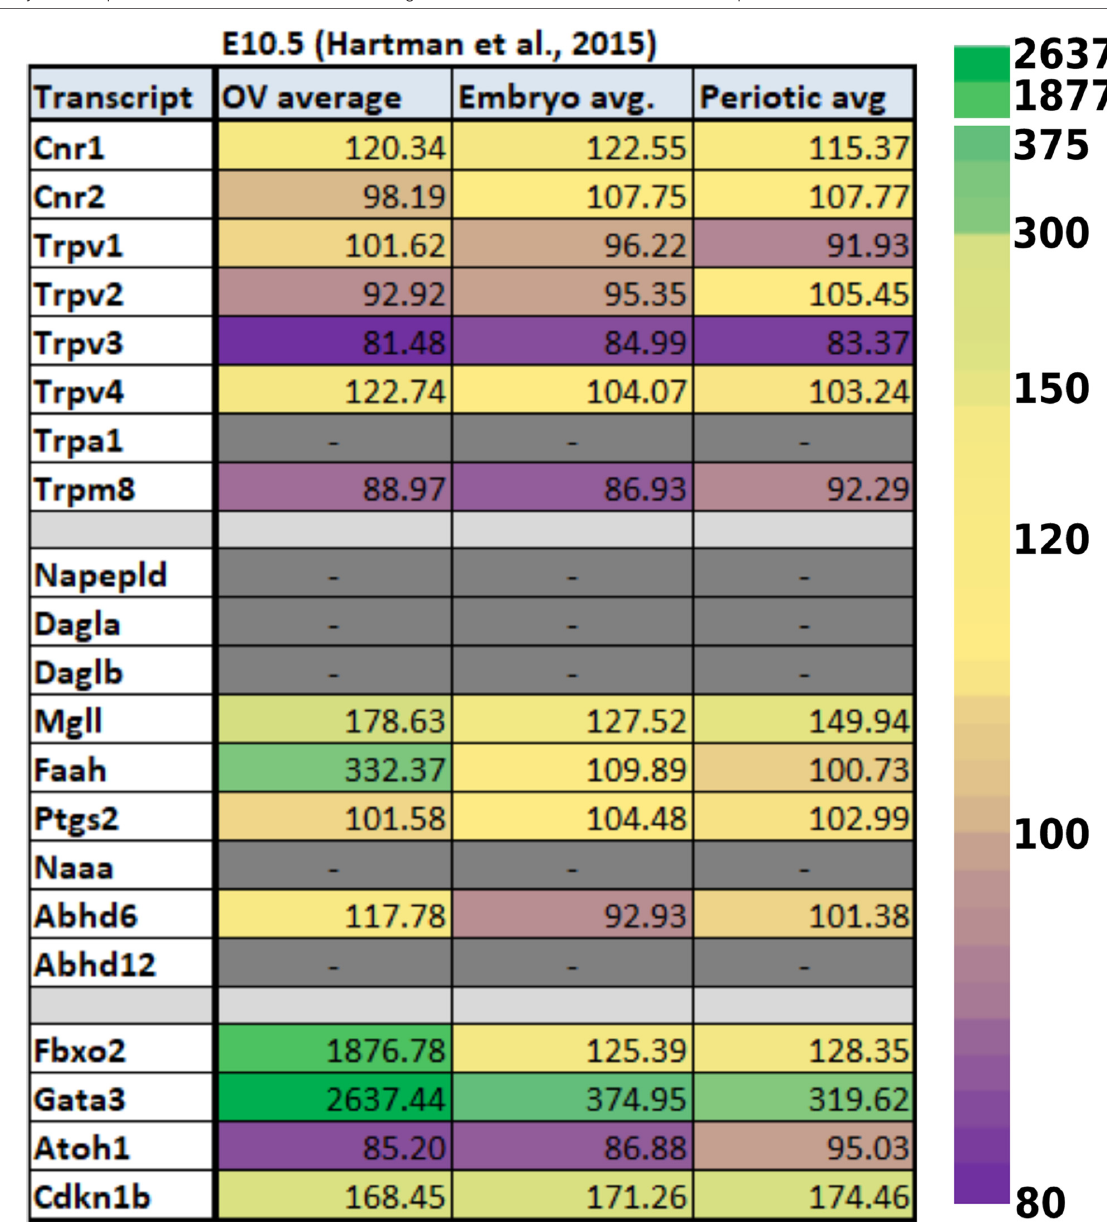
TABLE 1 | Expression of ECS-related transcripts from reported RNA-seq values using E10.5 otic vesicles and surrounding tissues. Data from E10.5 was obtained from Hartman et al. (2015) and are presented as untransformed microarray probe intensities. The last four rows demonstrate values obtained for transcripts known to